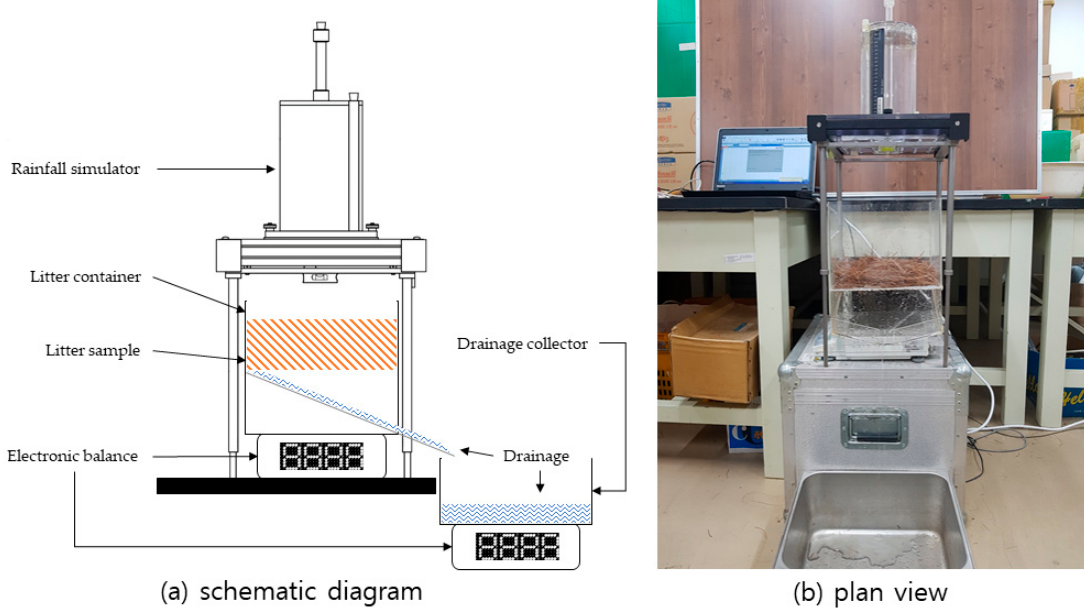
Figure 1. Rainfall simulation apparatus: ( a ) schematic diagram, and ( b ) plan view.